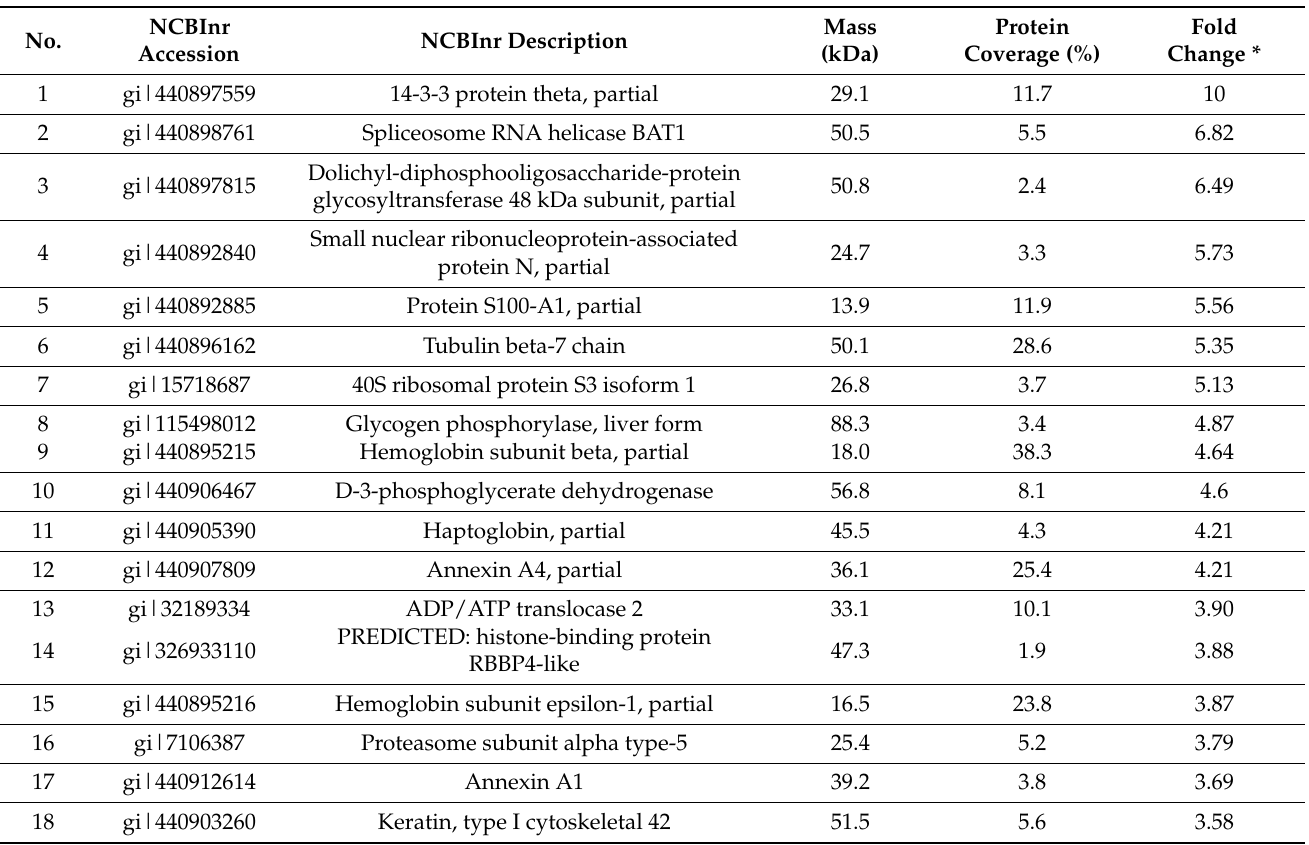
Table 1. The top 50 up-regulated skim milk proteins in HL yaks.